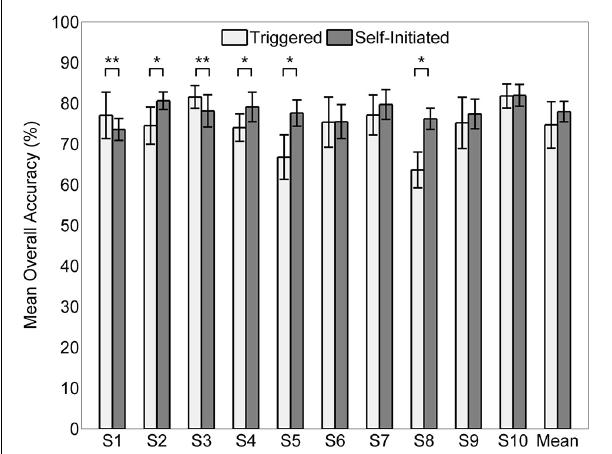
FIGURE 7 | Mean accuracy ( n = 20) by subject for decoding triggered and self-initiated sitting and standing from pre-movement EEG. Error bars indicate ± 1 standard deviation. Statistically significant within subject differences across conditions are indicated as follows: ∗ p < 0 . 01, ∗∗ p < 0 . 05.